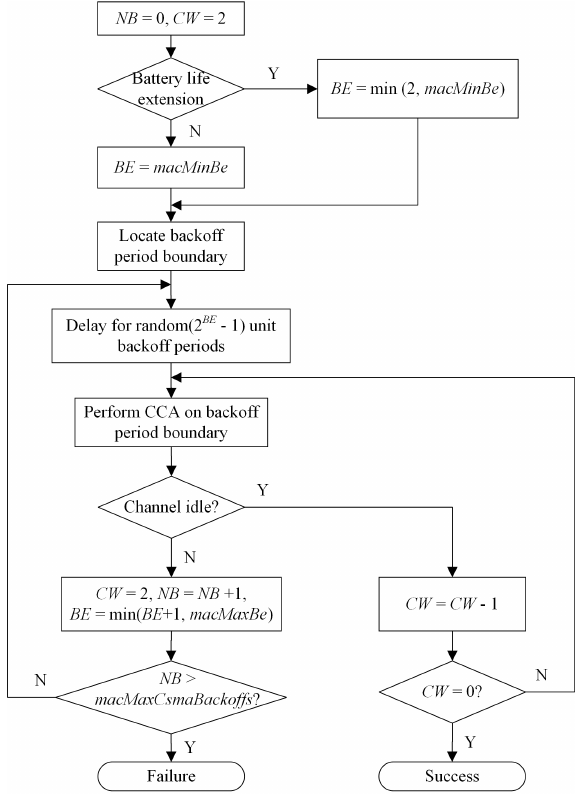
Figure 1. The procedure of the CSMA-CA algorithm